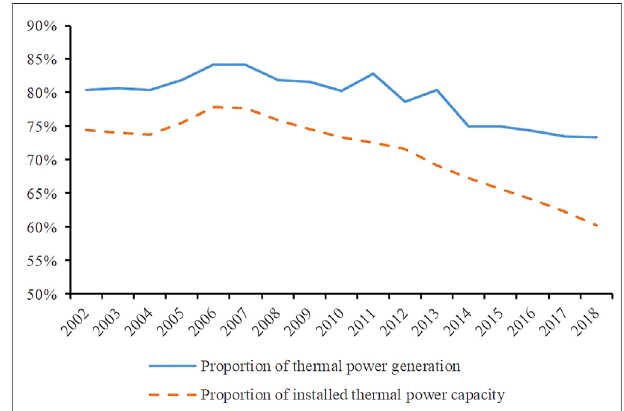
FIGURE 1 | Proportion of thermal power generation and installed capacity from 2002 to 2018.